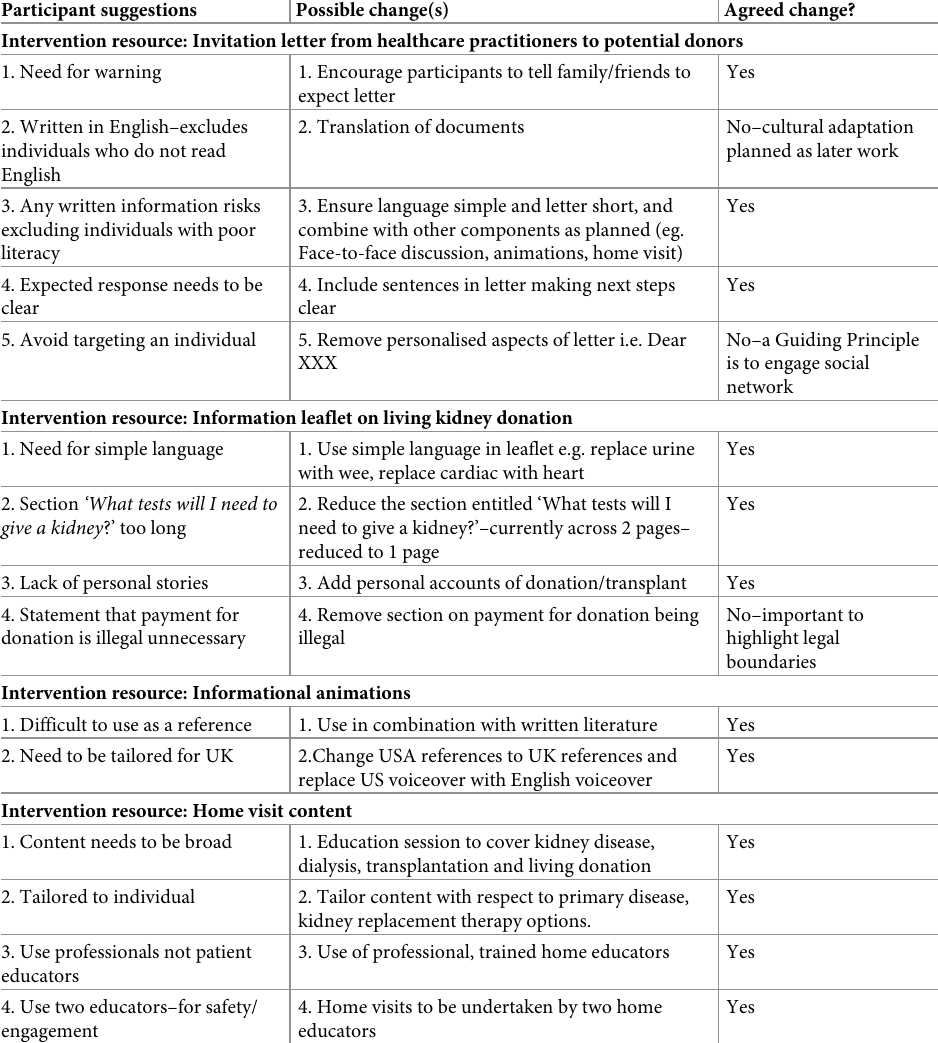
Table 5. Summary of changes to intervention components and resources (Summary of S1